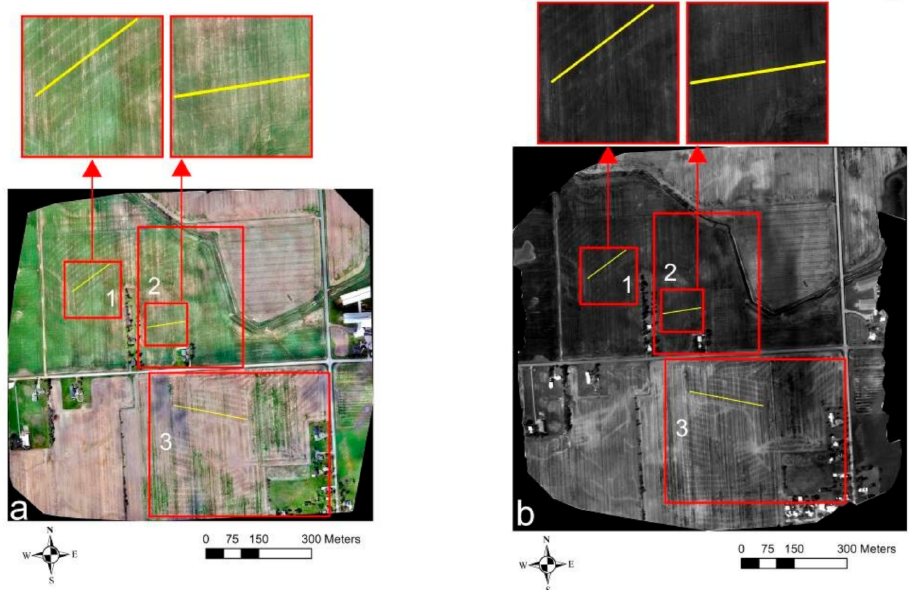
Figure 7. Site-2 UAV survey results from 7 May 2018: ( a ) VIS-C and ( b ) TIR orthomosaic imagery. Solid yellow lines indicate the drain lines’ directional trend. The red boundaries mark the different regions where the drainage pipe signatures were evidently